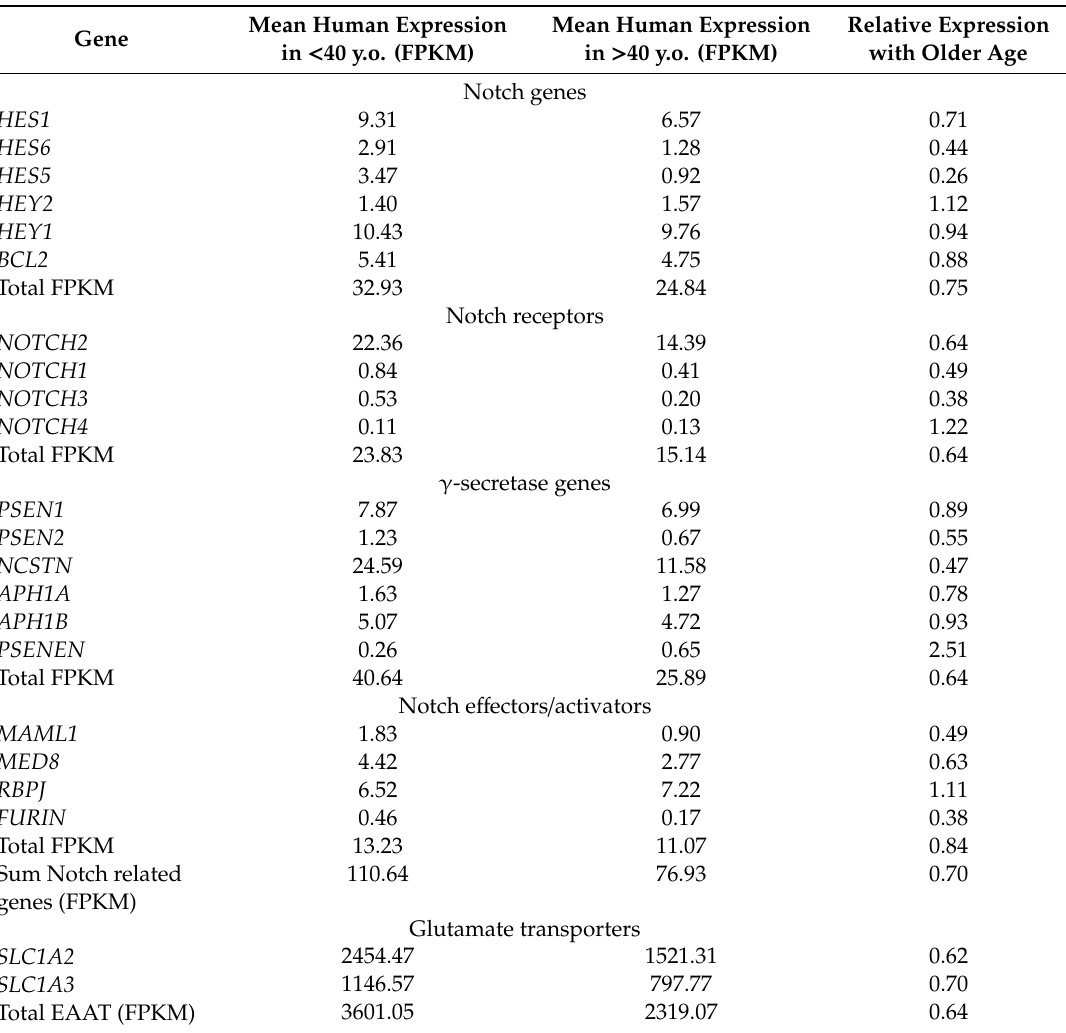
Table 4. Notch pathway and astrocytic EAAT expression in human astrocytes with age. There is a reduction in gene expression for both astrocytic EAAT transporters and Notch pathway associated genes with age in astrocytes isolated from human tissue. Mean Human Expression Mean Human Expression Relative Expression Gene in < 40 y.o. (FPKM) in > 40 y.o. (FPKM) with Older Age Notch